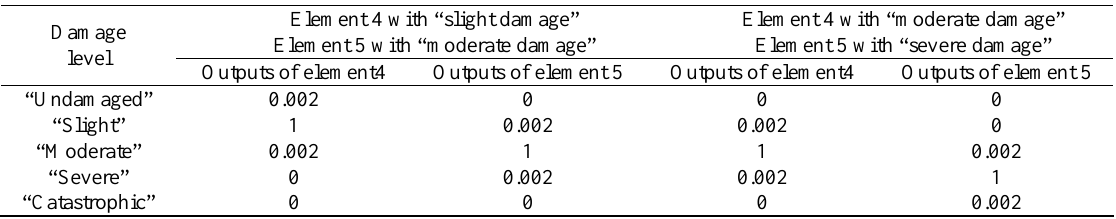
Table 11 Memory ability of fuzzy system for case 3